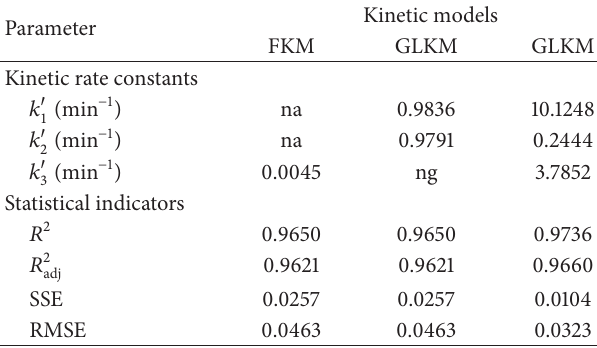
Table 1: FKM, GLKM, and GLKM kinetic rate constants and statis- tical